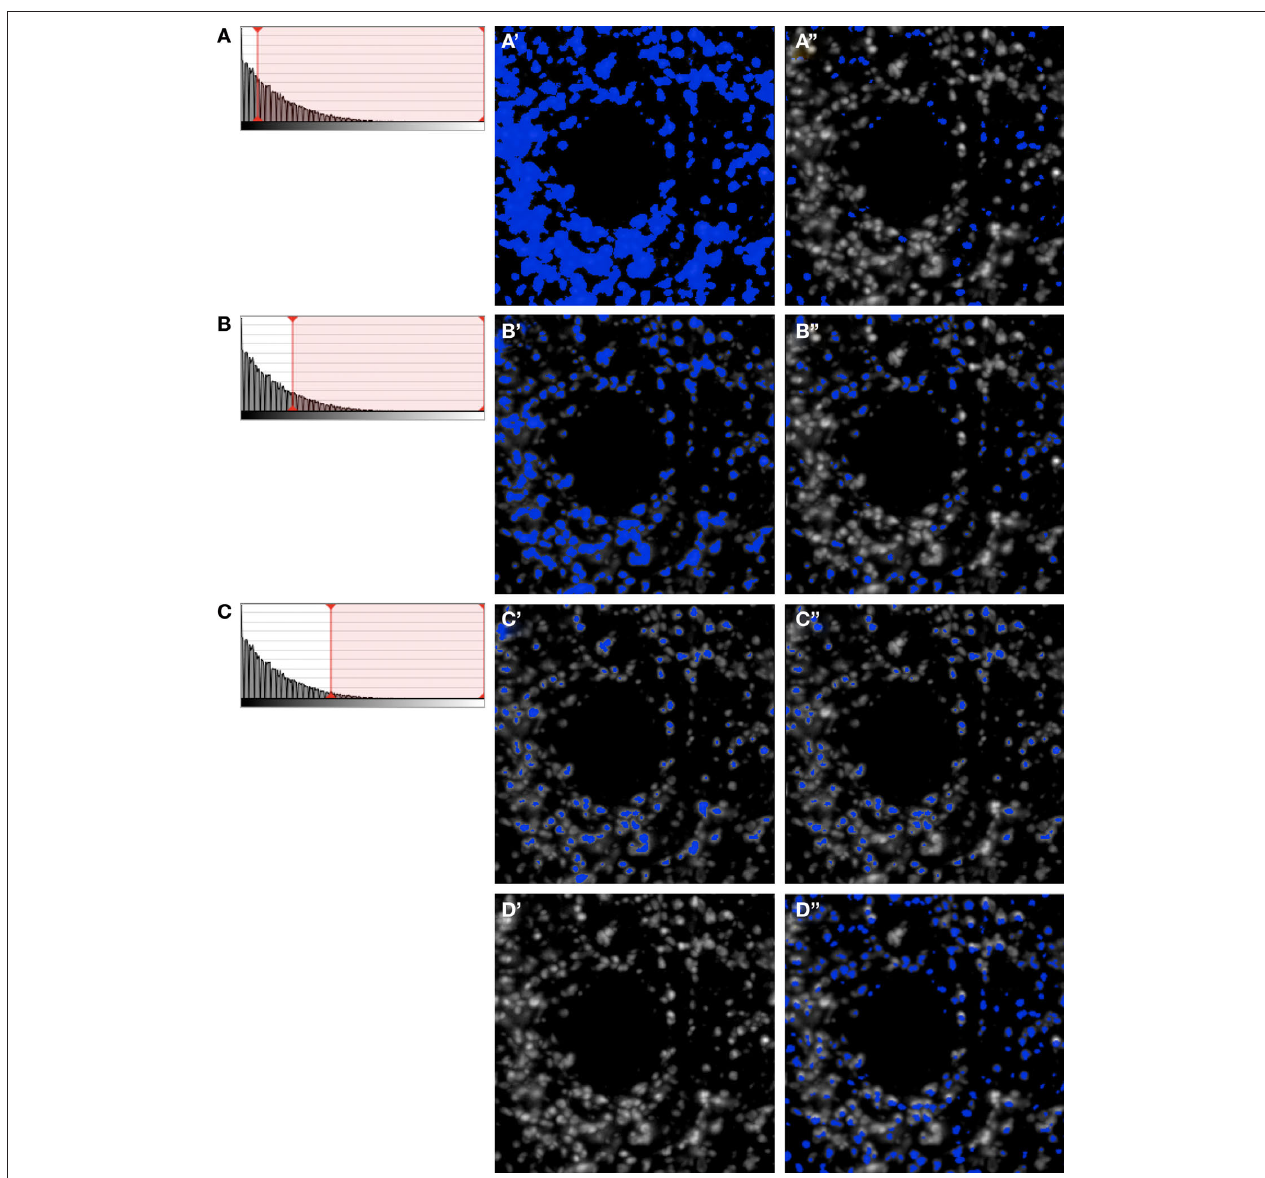
Figure 2 | iterative segmentation process for automated quantification of fluorescent structures (Fish et al., 2008 ). (A–C) Show the intensity histograms with the lower bounds for segmentation progressively migrating towards higher values, which results in fewer and fewer objects being masked (A ′ –C ′ ) . At each step, only mask objects within the selected size range are kept